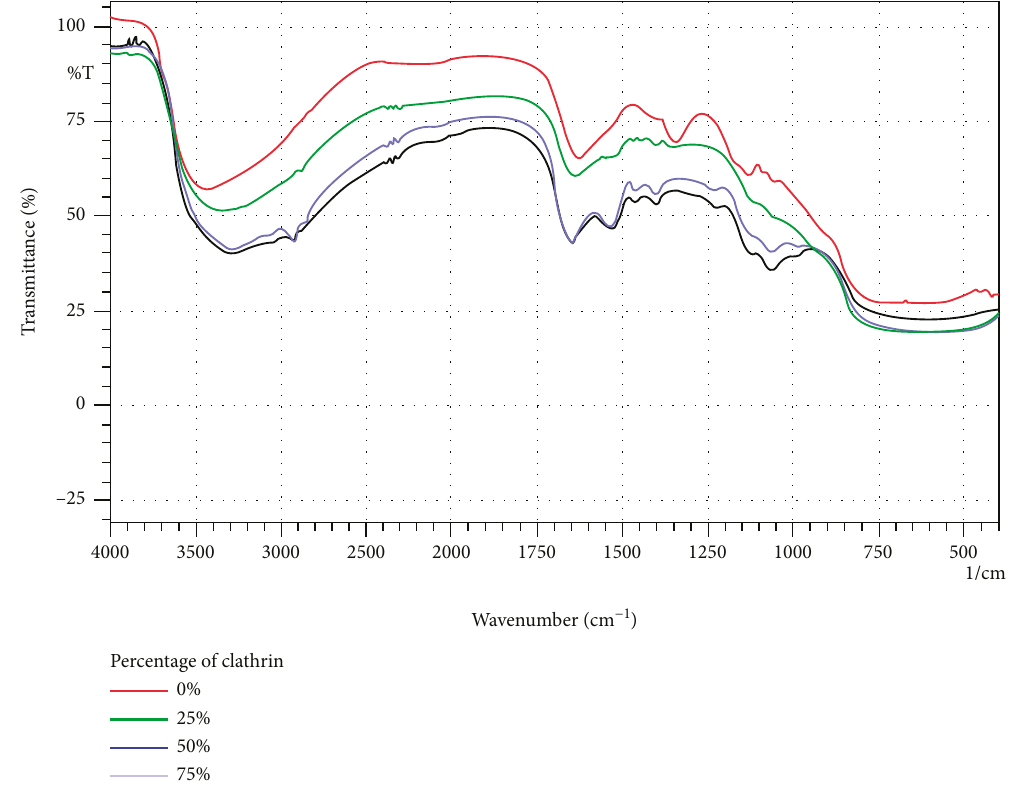
Figure 8: Function groups in DSSC for various percentages of clathrin.